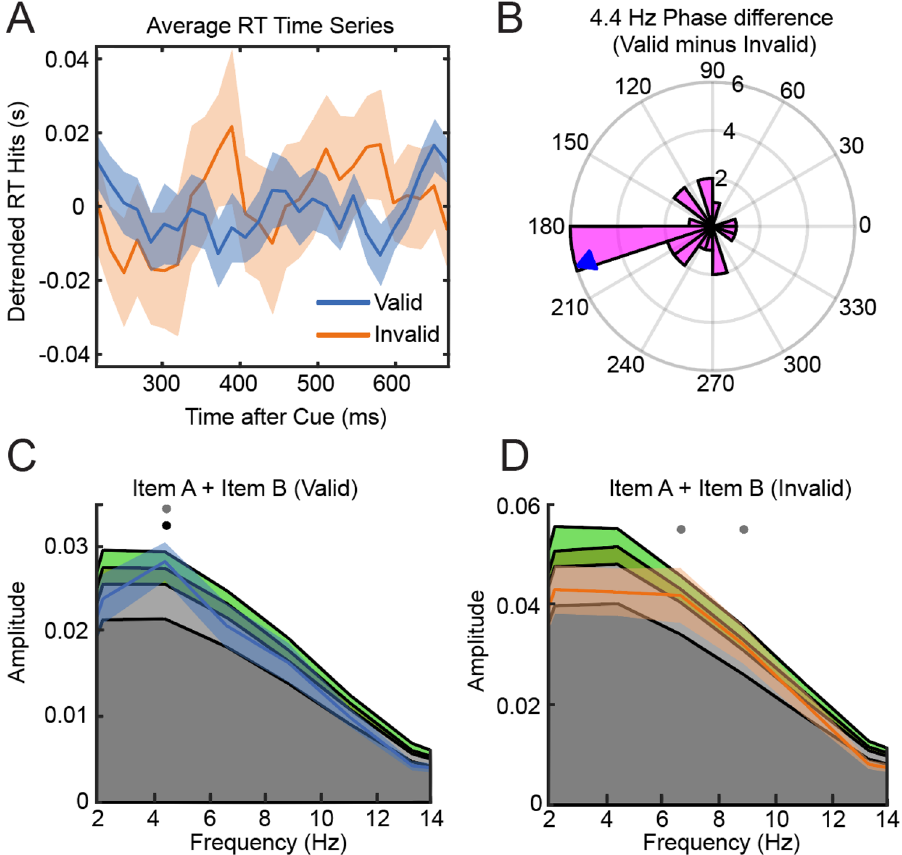
Figure 5. ( A ) Group average RT time series for valid and invalid trials. ( B ) 4.4 Hz Phase difference plot. ( C ) Power-spectrum RT time series valid condition. Colored areas in the background display quantiles of statistical null distribution (dark grey: Mean of permutation distribution, light grey: Power < 95% confidence interval, green: Power < 99% confidence interval). Dots indicate frequencies at which observed spectrum exceeded 95% of samples from permutation distribution (gray: significant before correction for multiple comparisons, black: significant after correction of multiple comparisons). ( D ) Same as C but RT time series of Invalid